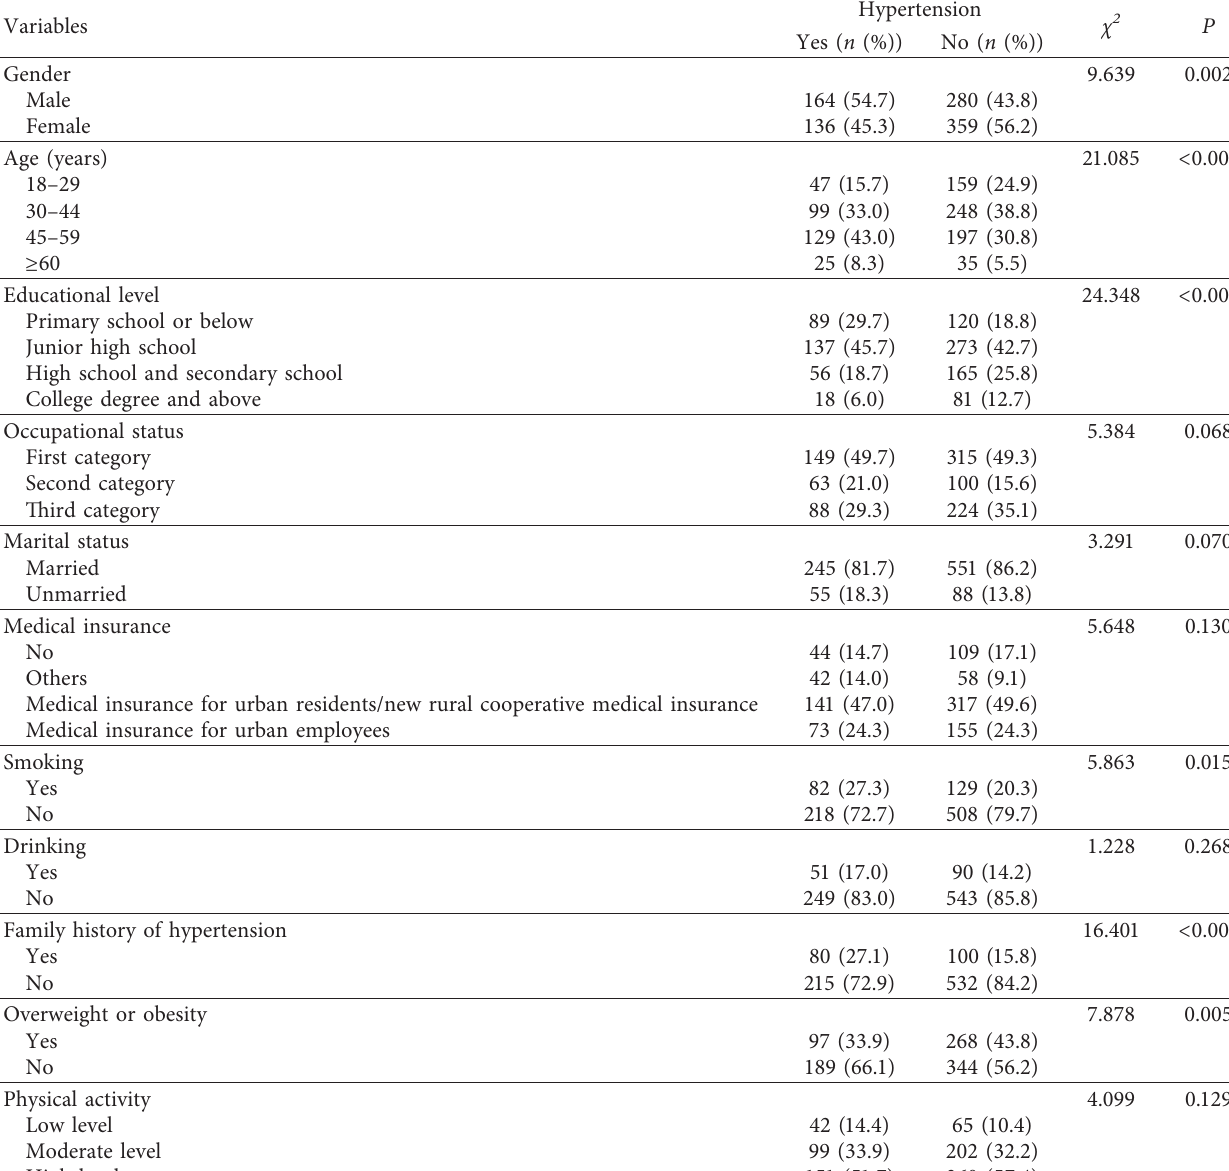
Table 2: Univariate analysis of influencing factors of